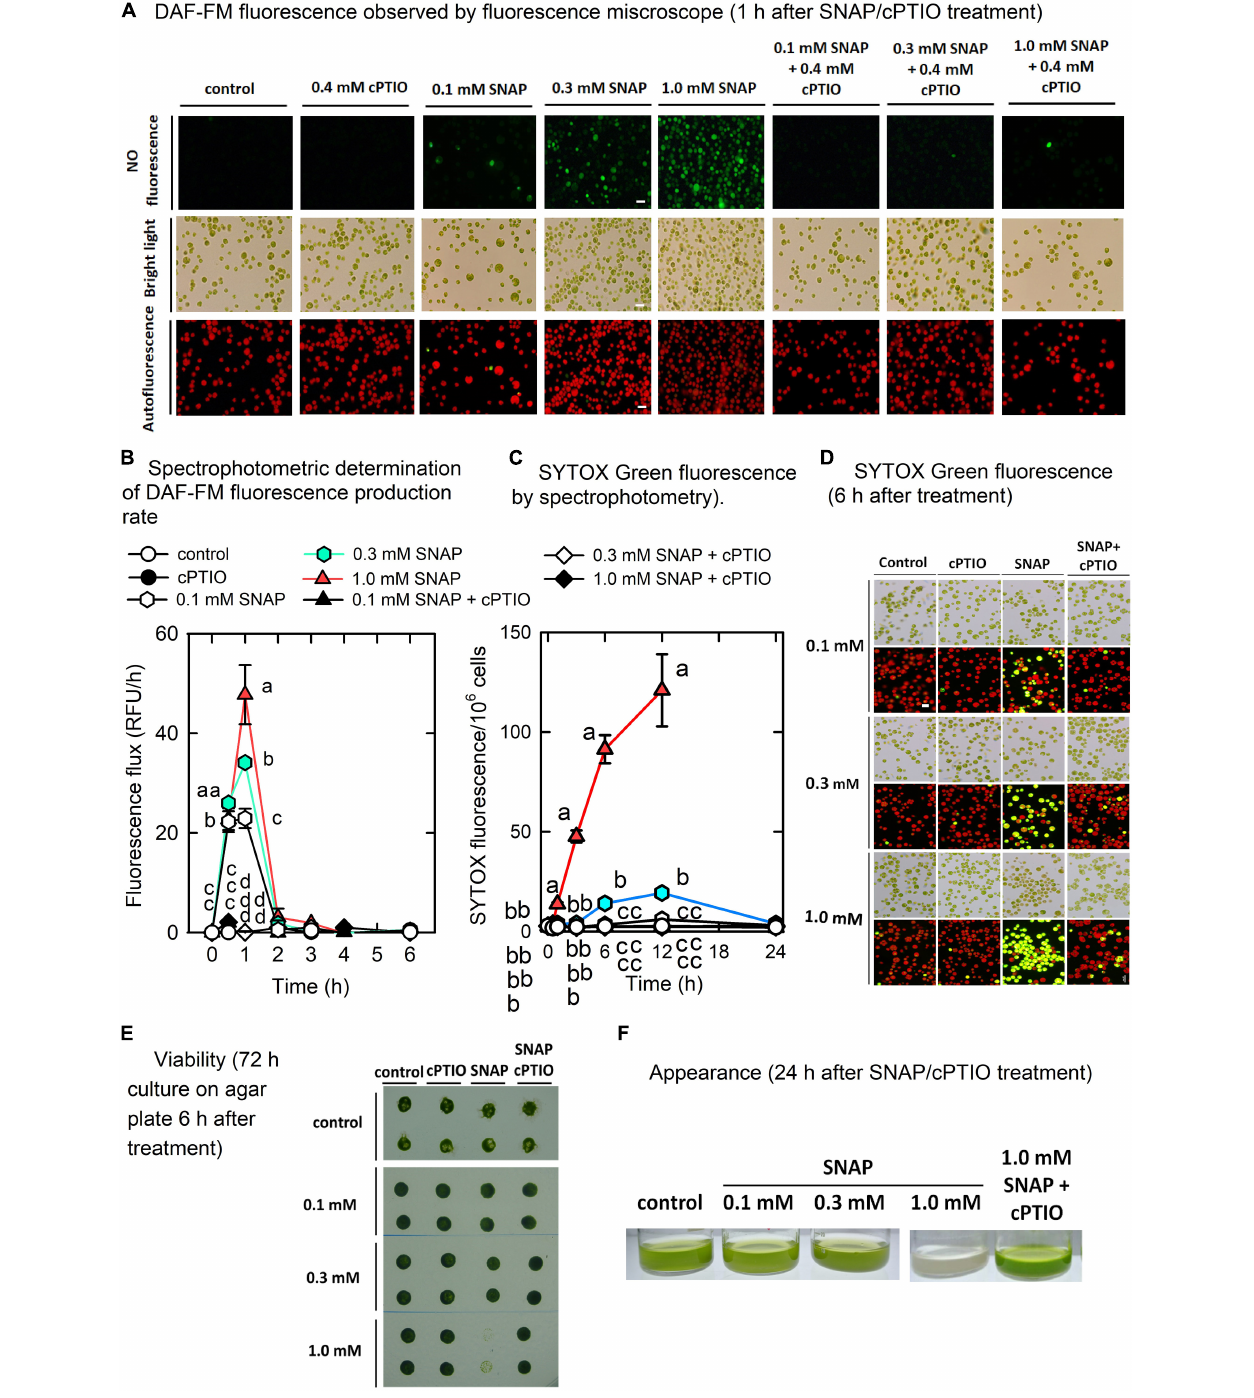
FIGURE 1 | Physiological response to NO. Microscopic observation (A) and spectrophotometric determination (B) of nitric oxide fluorescence (DAF-FM), spectrophotometric quantitative determination of SYTOX Green fluorescence (C) , microscopic observation of SYTOX green staining (D) , cell viability (E) , and appearance (F) in Chlamydomonas reinhardtii in response to 0.1, 0.3, or 1.0 mM SNAP in the presence or absence of 0.4 mM cPTIO. For cell viability assay, the cells were treated with chemicals for 6 h and then transferred to agar plate for another 72 h. Data are expressed as the mean ± SD ( n = 3). Different symbols indicate significant differences between treatments (Scheffe’s test, P <